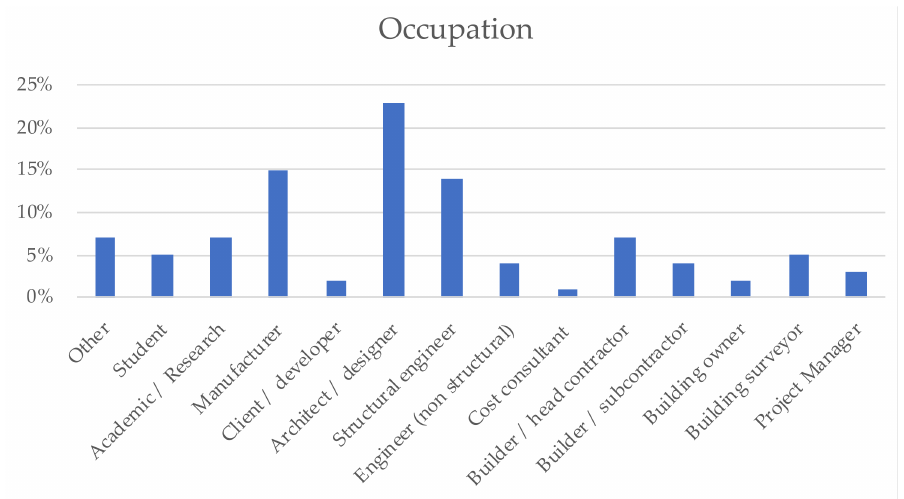
Figure 2. Respondents by occupation. Most respondents declared to be based and mainly active in Australia in the states of Victoria (26%), New South Wales (20%), or Queensland (16%), followed by Western Australia (9%), South Australia (4%), and Tasmania (3%). Participation was recorded also from the Australian Capital Territory (ACT; 2%) and Northern Territories (<1%). This distribution reflects broadly the Australian population along the East Coast, although with some over-representation from Victoria and under-representation from New South Wales. Details are shown in Figure 3.